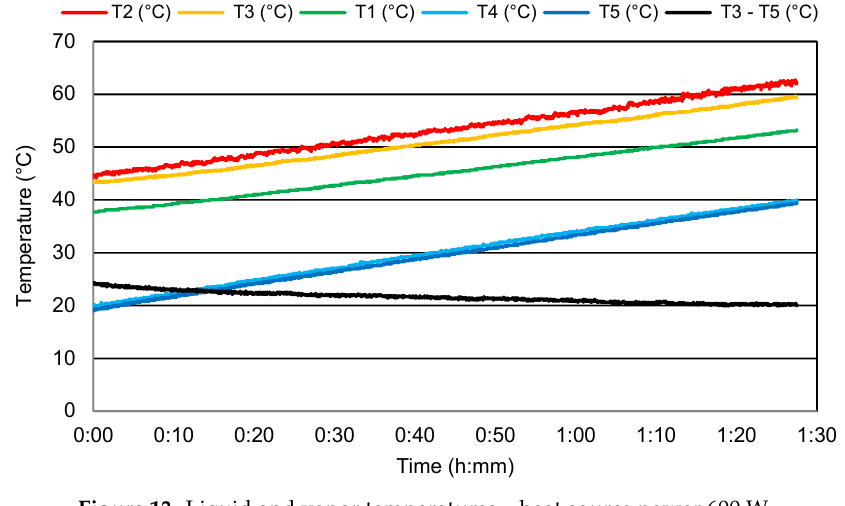
Figure 13. Liquid and vapor temperatures - heat source power 600 W.